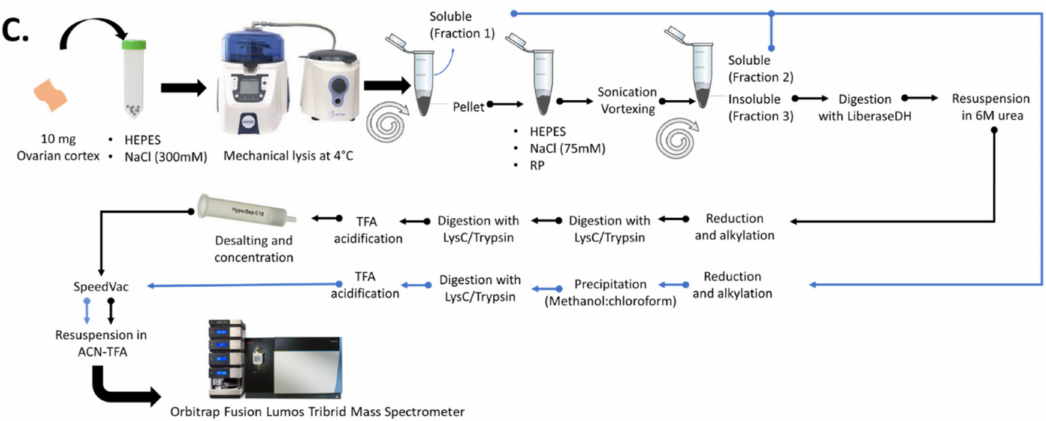
Figure 5. Three-step fractionation procedure outcomes. ( A ) Heatmap of matrisome protein abundance within the 3 obtained fractions highlights the localization of the majority of identified proteins in fractions 1 and 2. ( B ) Some proteins were exclusively detected in fraction 3, but their detection (abundance as a percentage in fraction 3) was very variable between the 6 tested replicates, as shown by the color and size of markers. ( C ) Summary of the three-step fractionation